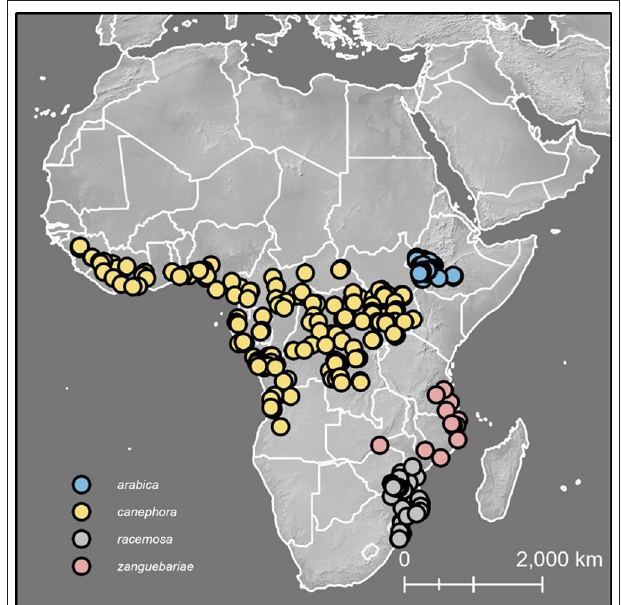
FIGURE 1 | Distribution map for C. arabica , C. canephora , C. racemosa and C. zanguebariae . Figure also indicates ground point data for climate profiling analysis ( Figures 8 , 9